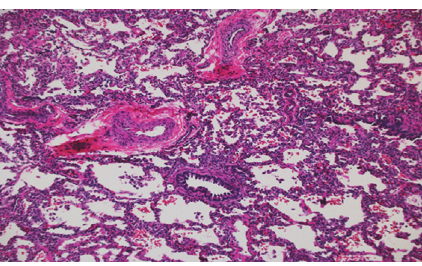
Figure 3: Pulmonary arteriopathy with moderate medial hypertro- phy and muscularization of the intralobular